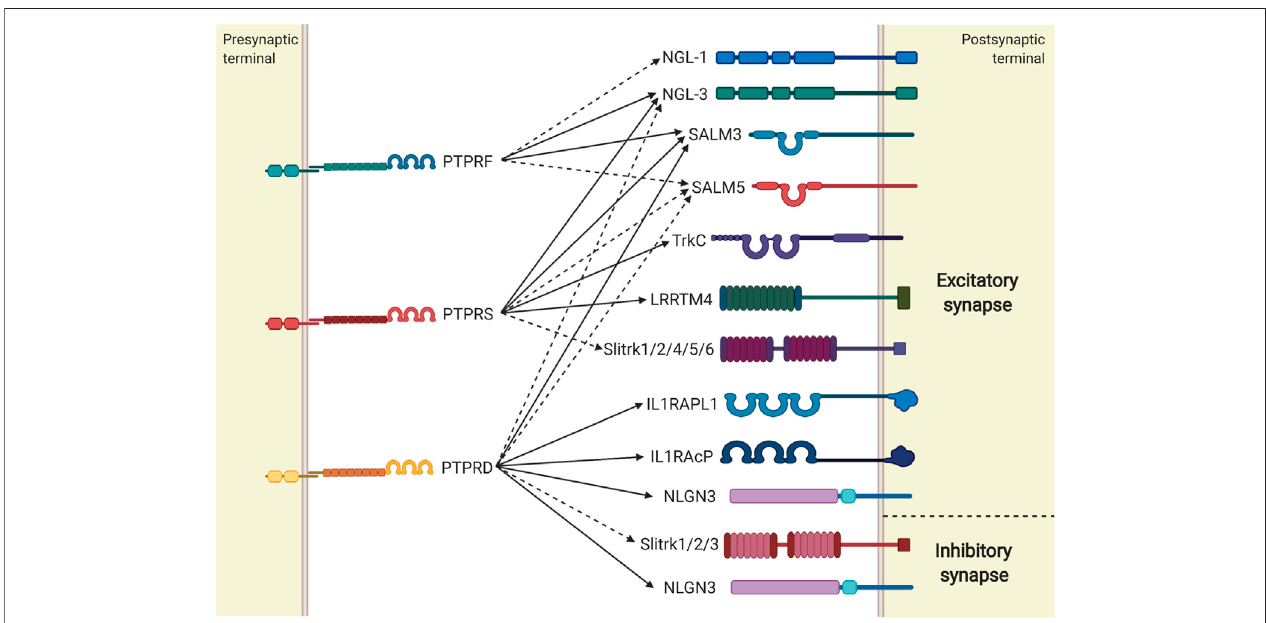
FIGURE4| LAR-RPTPs trans -synapticinteractionsinducesynapticdifferentiation.SummaryofLAR-RPTPsandtheirsynapticpartnerswhoseinteractionsinduce excitatory or inhibitory synapse differentiation. LAR-RPTPs interactions that induce differentiation unidirectionally are represented with dashed lines, while interactions inducing bidirectional differentiation are represented with solid